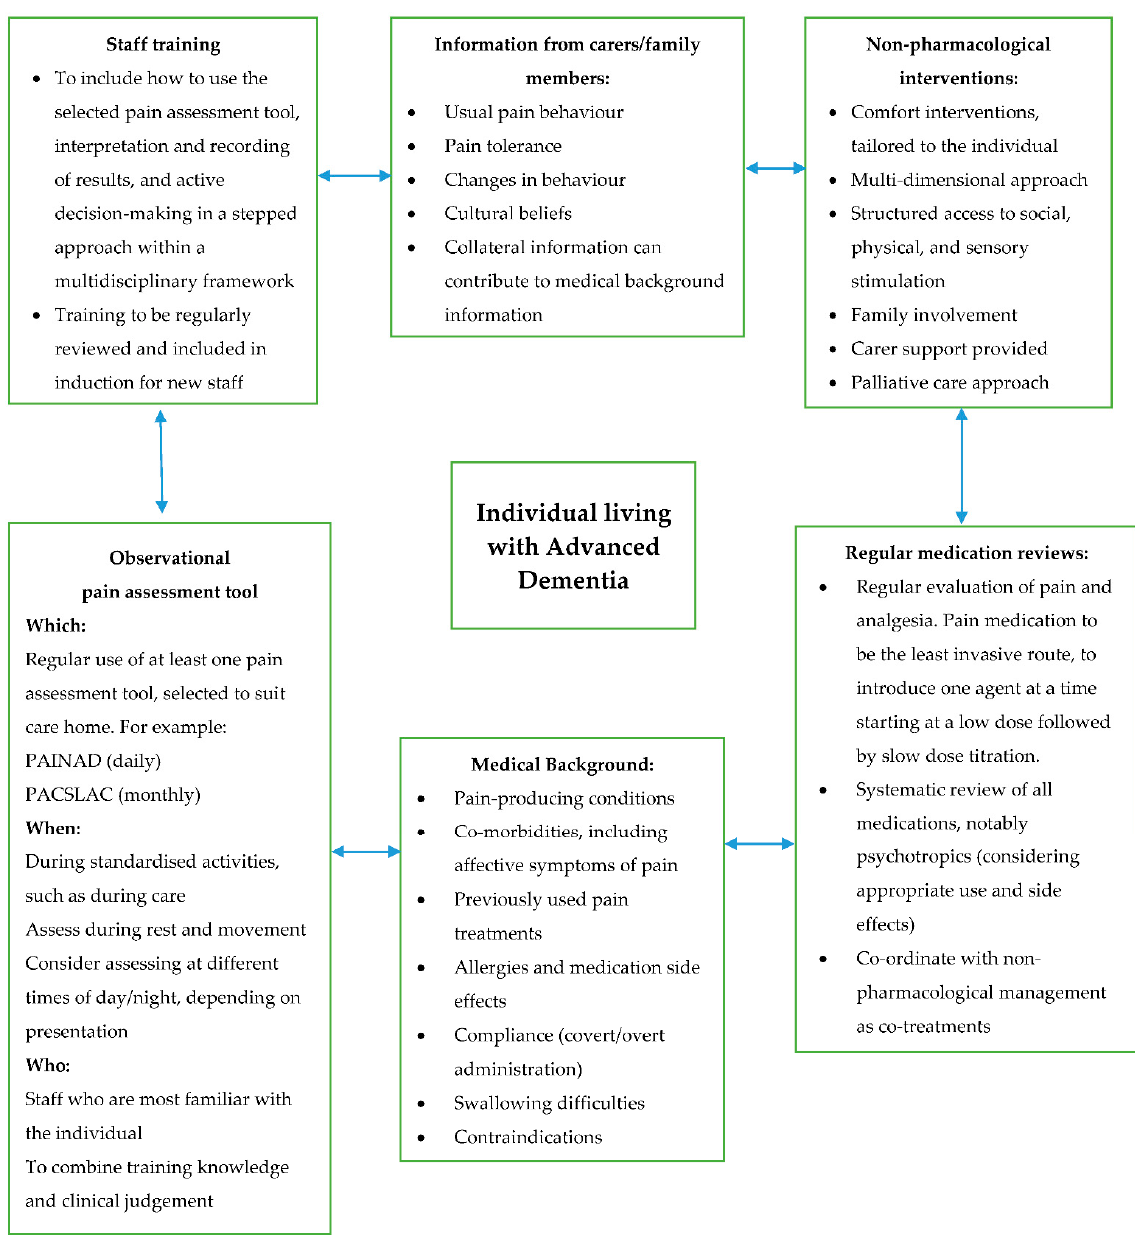
Figure 2. Conceptual Model. Integration of standardised and person-centred models of pain management for individuals living with advanced dementia in care homes.